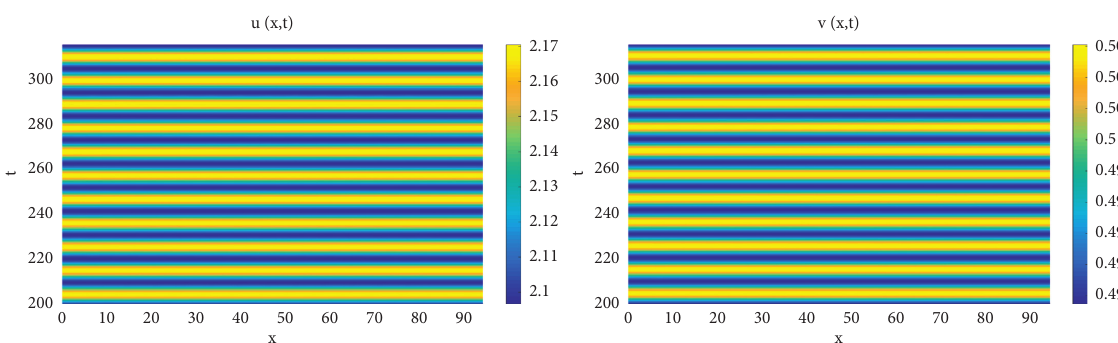
Figure 4: Numerical simulations of system (3) with τ � 2 . 54 and the initial condition at ( 2 . 1 + 0 . 0001 sin x, 0 . 5 − 0 . 0001 cos x )